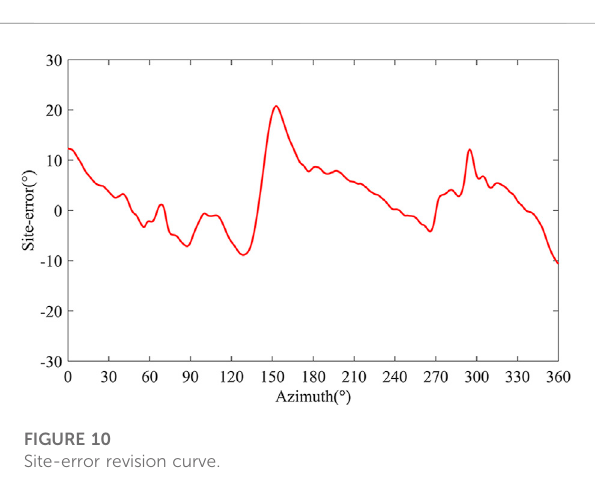
FIGURE 10 Site-error revision